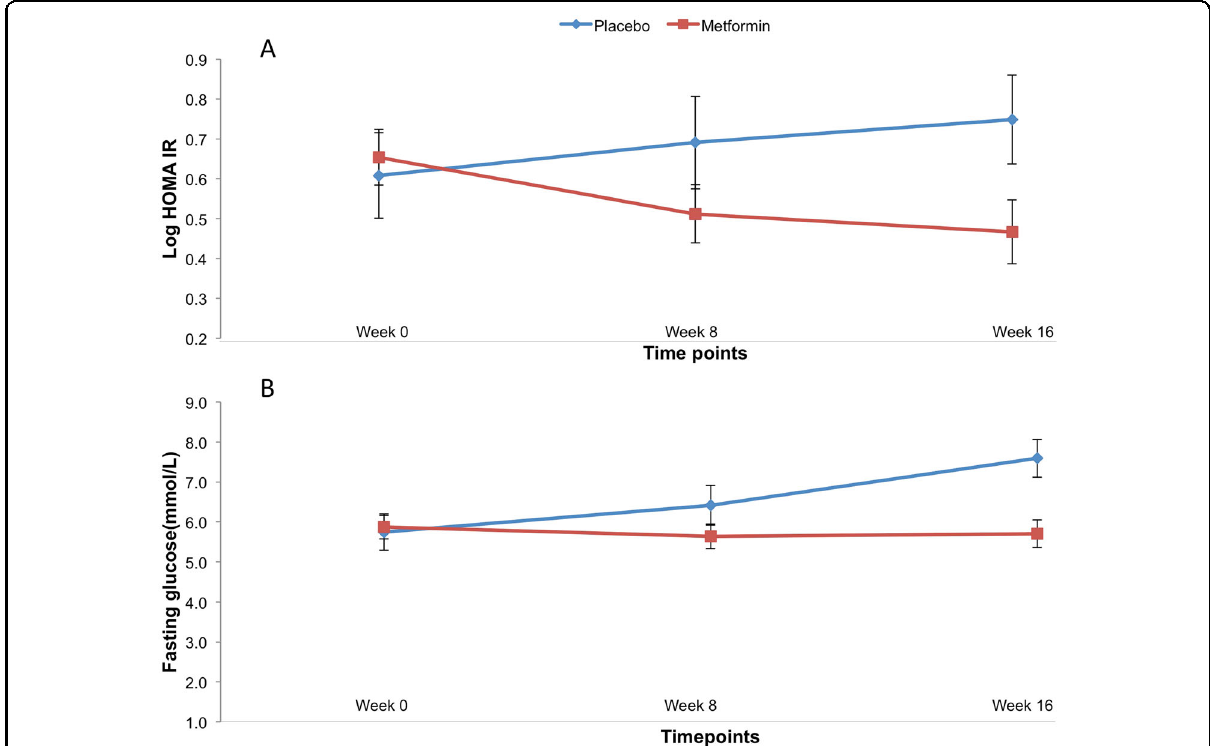
Fig. 2 Change in insulin sensitivity (HOMA-IR) (A) and fasting glucose levels (B) with metformin compared to placebo at baseline, 8 weeks, and 16 weeks of treatment. Error bars represent ± 1